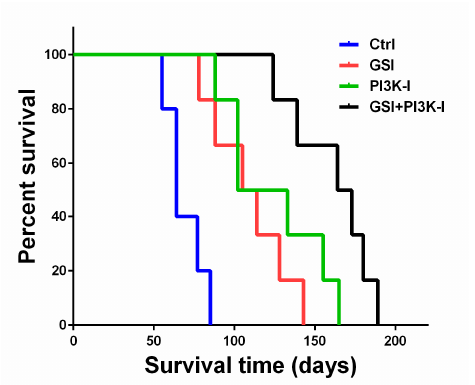
Figure 6. The combination of a GSI and PI3K inhibitor had a synergistic effect in PTEN ‐ mutant GIC. Kaplan–Meier survival probability plots of tumor ‐ bearing mice in vehicle or RO4929097, BKM120 and combined RO4929097 and BKM120 treatment groups were graphed, and the log ‐ rank test was used to compare groups. All treatments (different colored lines) showed a statistically significant improvement versus control ( p < 0.05).